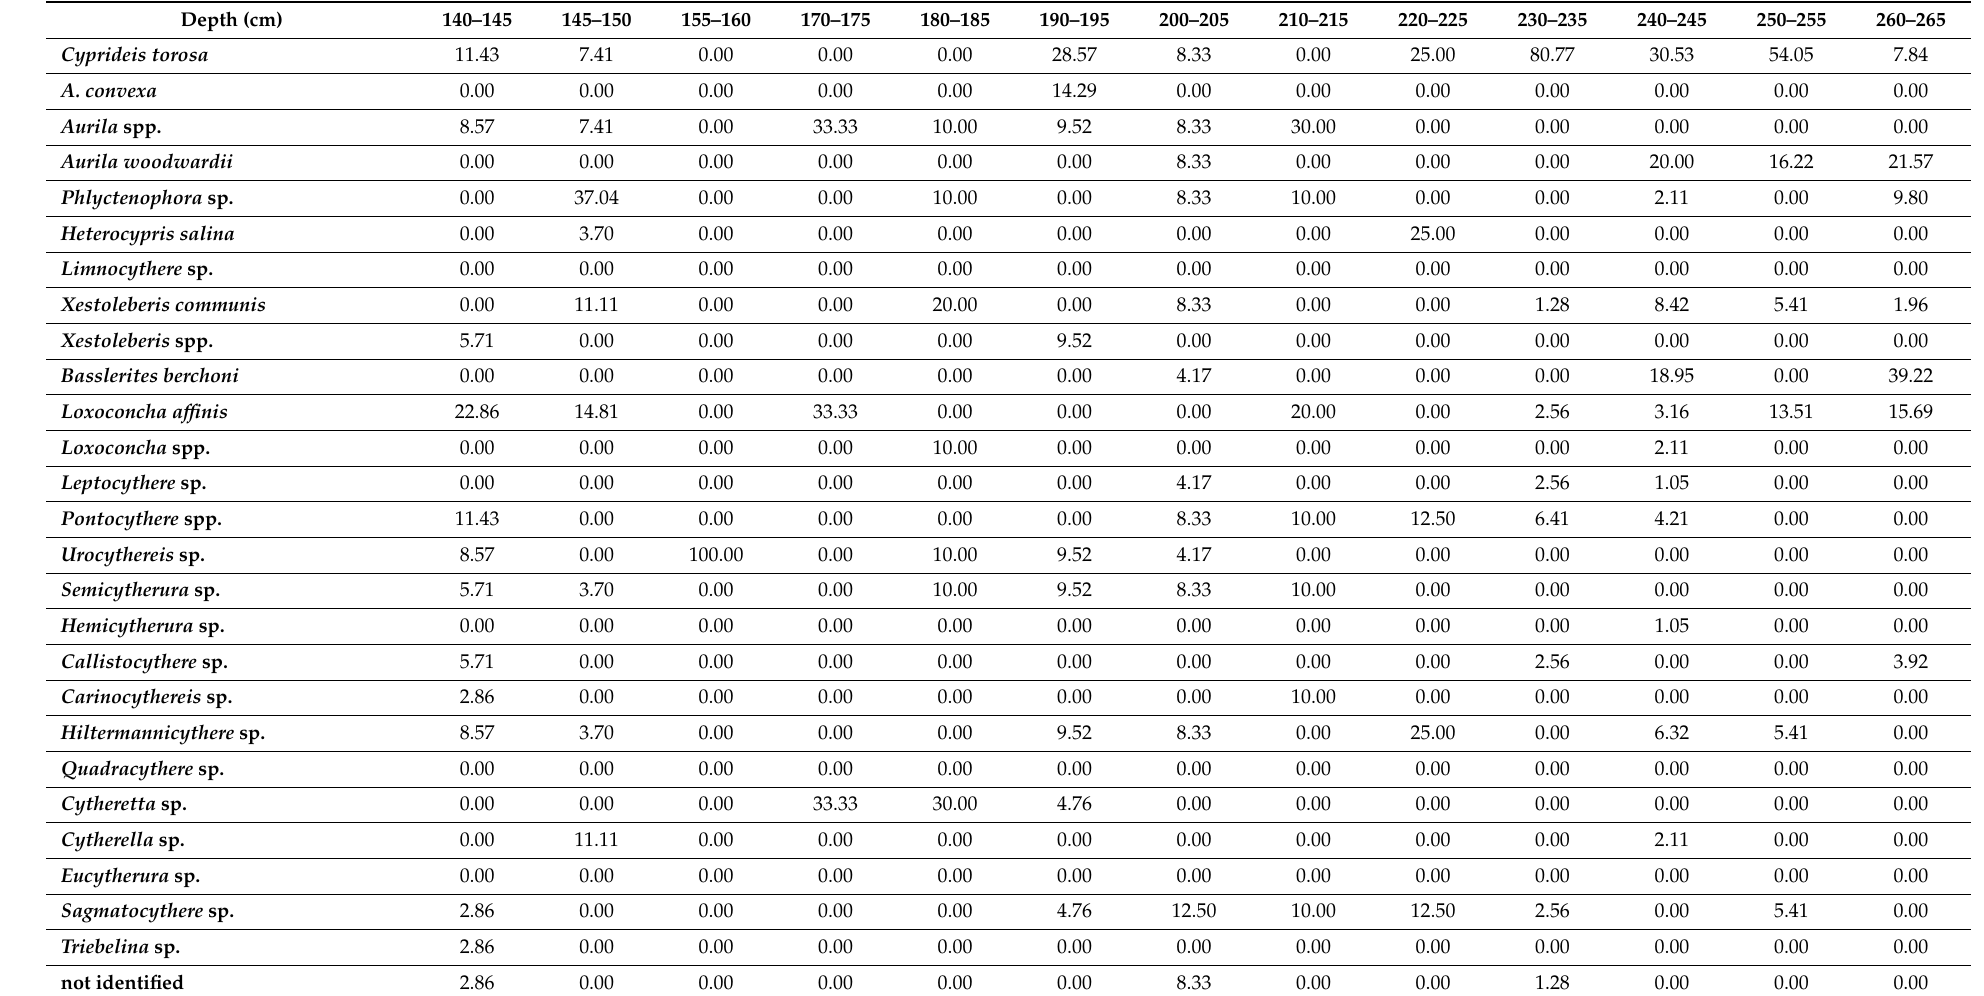
Table A5. Relative frequencies of the ostracod species in the studied samples of AKC1 (140 to 265